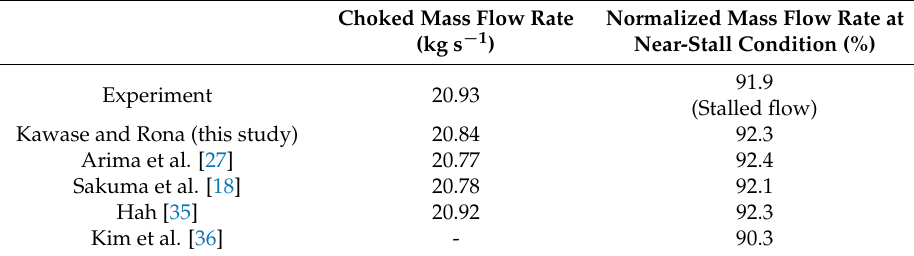
Figure 6. Overall performance characteristics of the NASA Rotor 37. Comparison between the current predictions and the experimental data. ( a ) Total pressure ratio; ( b ) adiabatic efficiency. Table 2. Comparison of choked mass flow rate and of mass flow rate at the near-stall condition.